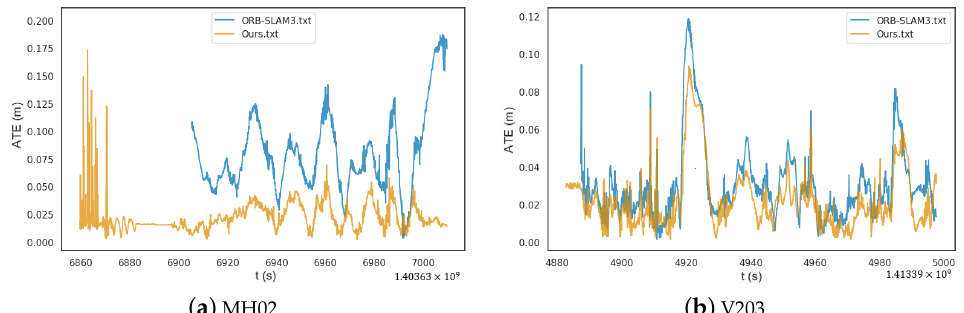
Figure 6. Comparison of ATE (raw date). ( a ) and ( b ) are the ATE comparison between the proposed algorithm and ORB-SLAM3 in MH02 sequence and V203 sequence respectively. The yellow line represents the result of the proposed algorithm, and the blue line represents the result of ORB-SLAM3.